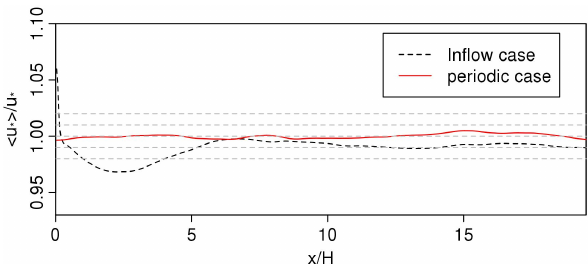
Figure 3. Spatial variation of (cid:104) u ∗ (cid:105) /u ∗ for the periodic case and the inflow case (LS1.0), where (cid:104) u ∗ (cid:105) is the y − t -averaged local friction velocity and u ∗ is the x − y − t -averaged friction velocity for the periodic